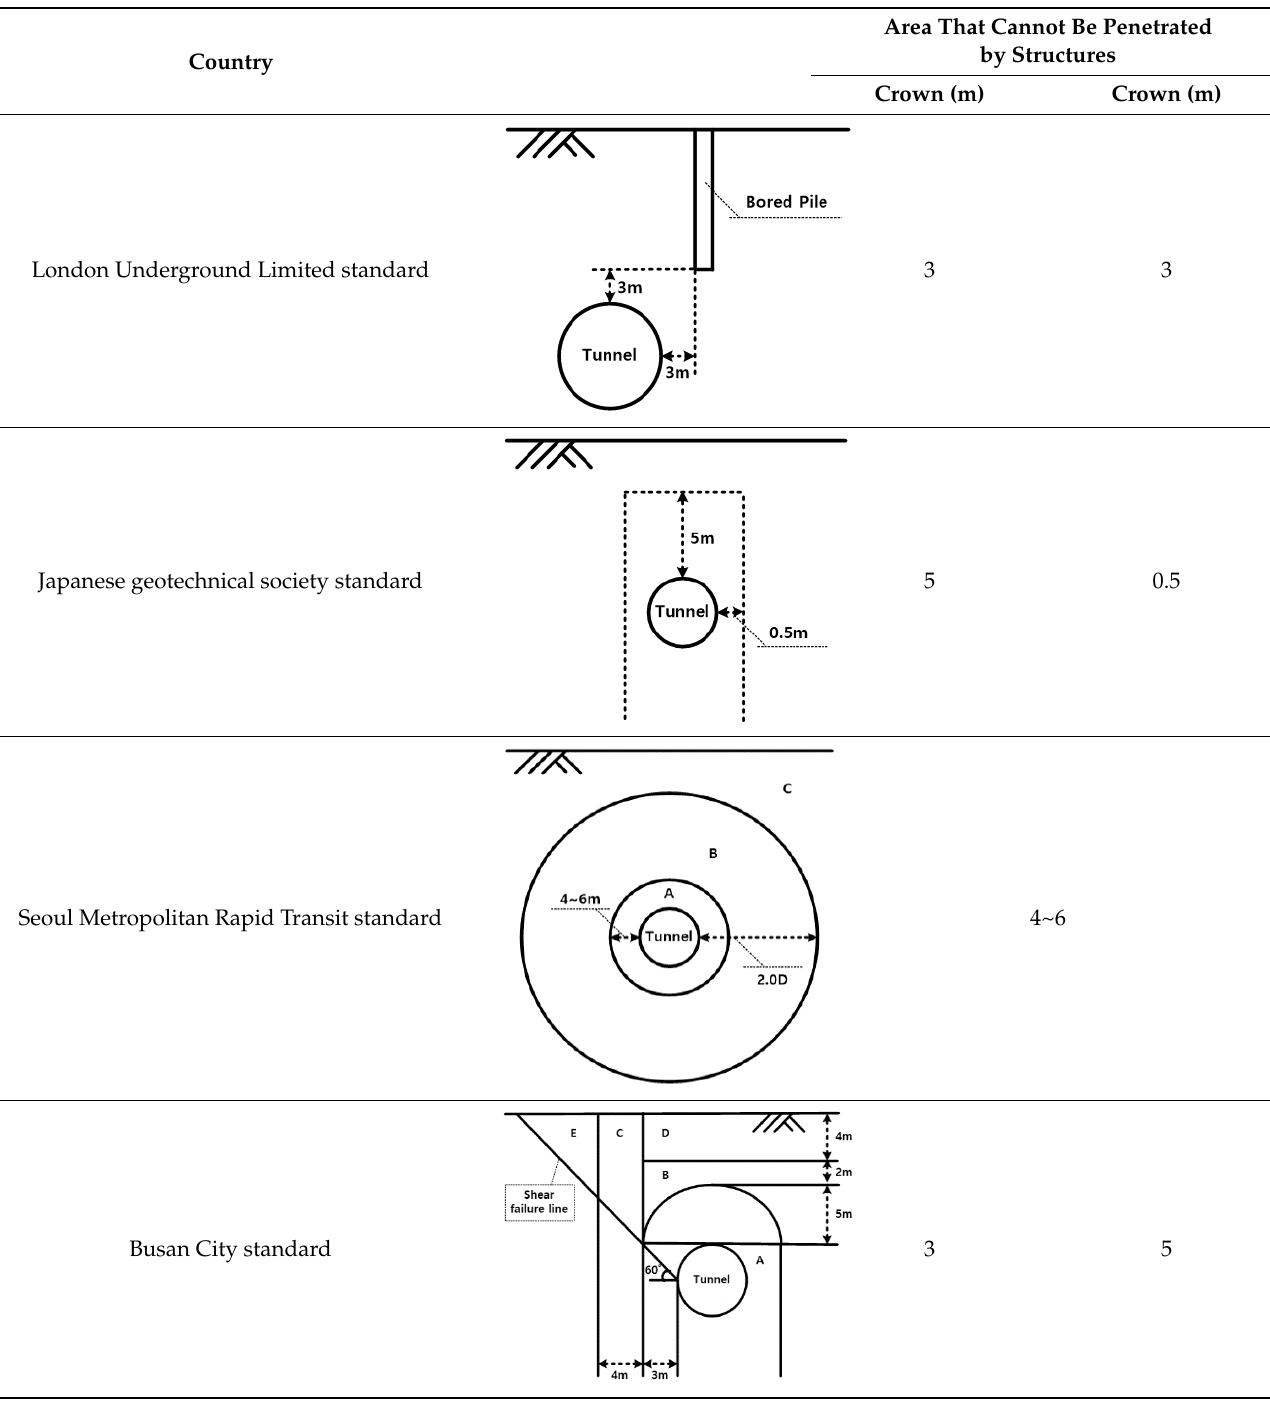
Table 1. Regulatory standards for tunnel stability near pile construction.